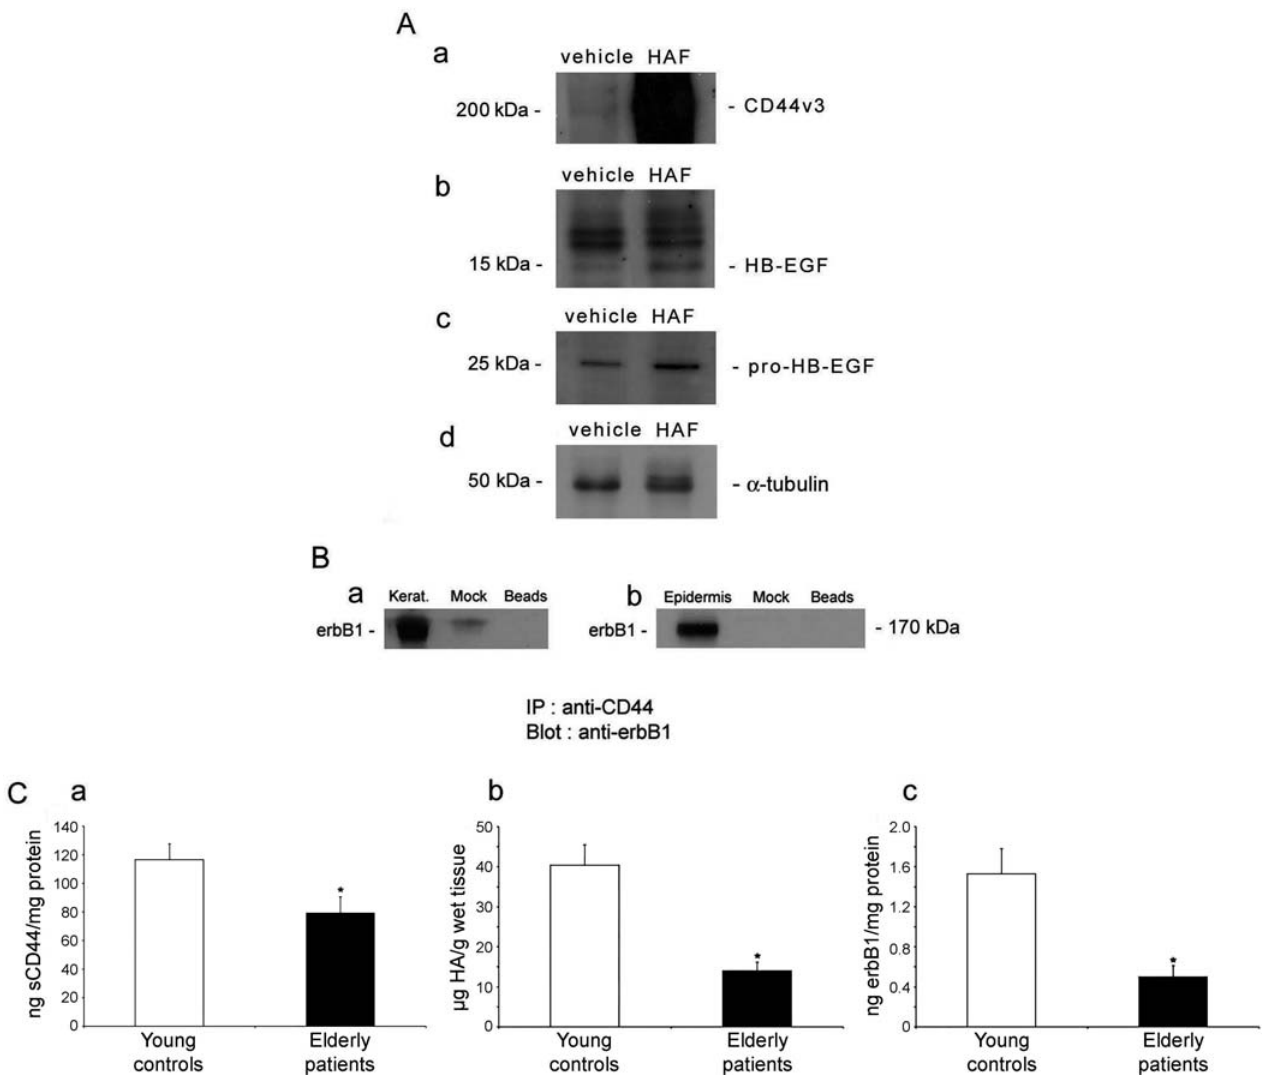
Figure 4. The Effect of HAF on CD44v3, pro-HB-EGF, and HB-EGF in Mouse Skin; CD44 and erbB1 Association In Vitro and In Vivo; CD44, HA, and erbB1 Levels in Young and Elderly Skin (A) HAFi induces expression of CD44v3, pro-HB-EGF, and active HB-EGF in mouse skin. Western blot analysis on the protein extracts of vehicle- or HAFi- treated SKH1 hairless mice for CD44v3 ( ; 200 kDa [a]), active HB-EGF ( ; 15 kDa [b]), pro-HB-EGF ( ; 25 kDa [c]), and loading control a -tubulin (50 kDa [d]). (B) CD44 associates with erbB1 in keratinocytes in vitro and in vivo. Western blot analysis of anti-CD44 antibody immunoprecipitates of protein extracts of cultured keratinocytes (a) or epidermis of DBA/1 mouse skin immunoblotted with anti-erbB1. Mock, isotype-matched rat IgG; beads, protein A þ G agarose beads treated with anti-CD44 antibody. (C) CD44, HA and erbB1 levels are diminished in atrophic human skin. CD44 (a), HA (b), and erbB1 (c) expression in forearm skin biopsy specimens of young adults (control) and elderly patients with skin atrophy. The results are presented as the mean CD44, HA, or erbB1 concentration 6 SEM of three subjects per group. * p , 0.05 versus young controls (Student’s